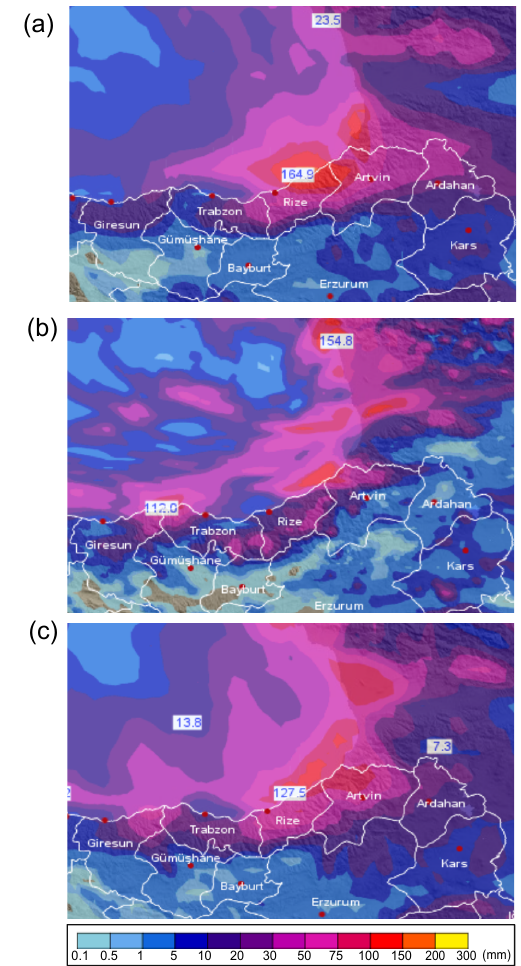
Figure 9. Numerical weather prediction (NWP) precipitation fore- casts for the 24h daily precipitation totals belonging to the 24 Au- gust 2015 in the EBS region (a) for ECMWF (b) for ALARO and (c) for WRF. Source: Turkish State Meteorological Service